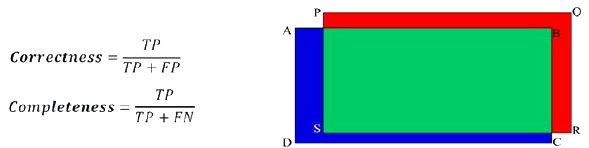
Figure 5. Equations for the correctness and completeness accuracy measurements based on the accuracy indicator: false positive (FP, red), false negative (FN, blue), and true positive (TP, green) (Joshi,